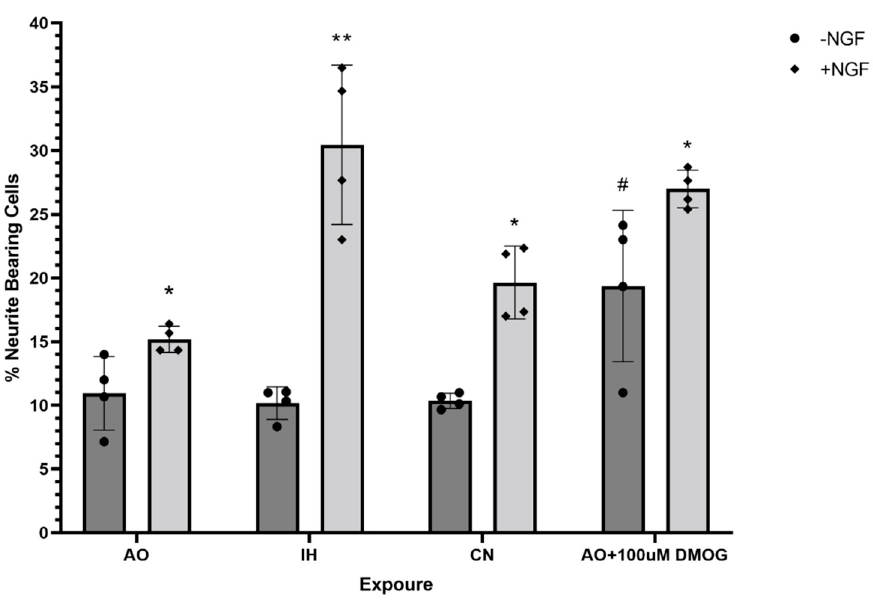
Figure 9. PC12 cell differentiation under three different culture conditions and with DMOG, with or without nerve growth factor. PC12 cells were cultured in collagen IV precoated 24-well plates with and without nerve growth factor (NGF) stimulation for 7–10 days under three different oxygen culture conditions and with DMOG (0.1 mM). The histogram shows the percentages of neurite- bearing PC12 cells. A significant increase in the percentage of neurite-bearing PC12 cells was shown with the treatment of NGF and DMOG (0.1 mM). Data are presented as mean percentage of cells in a phase ± S.E.M, n = 4. Statistical significance of the assay was evaluated using one-way ANOVA with Tukey post hoc corrections. * ( p < 0.05) and ** ( p < 0.01) indicate significant difference in comparison to cultures without NGF treatment. # indicates significant difference in comparison to culture in AO without NGF treatment ( p < 0.05).